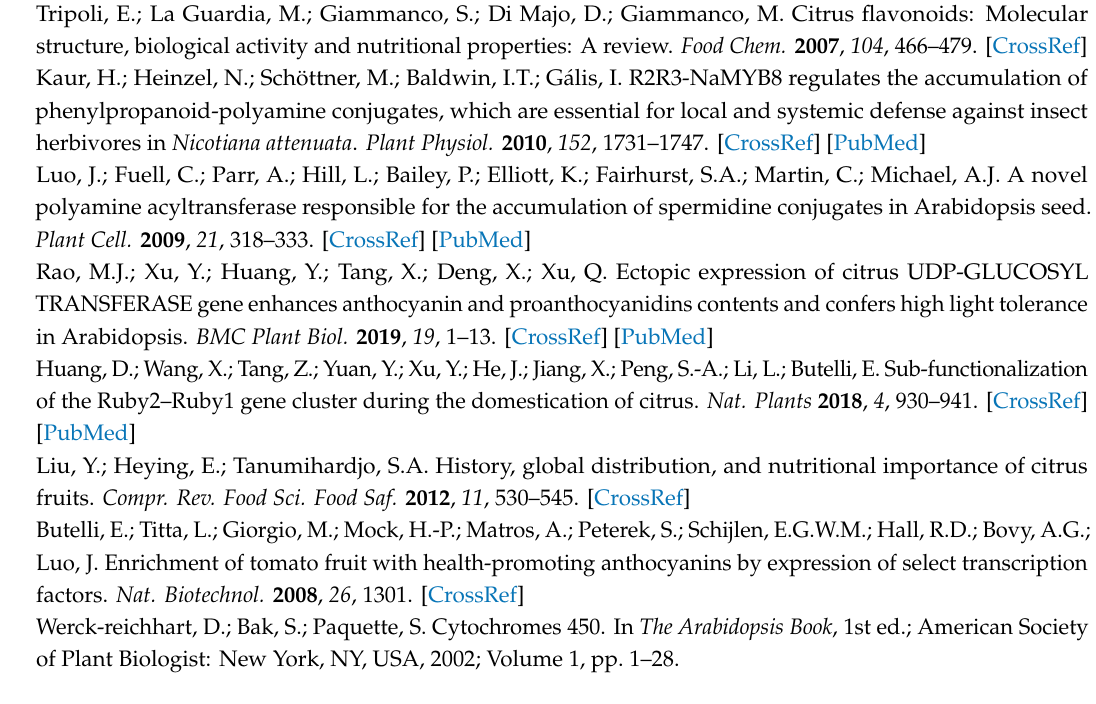
Figure S1. Heat map and hierarchical cluster analysis (HCA) performed by using the square of peaks of detected metabolites in di ff erent citrus germplasm. Figure S2. The gene expression pattern in citrus species at di ff erent stages. Figure S3. The gene expression results under drought and high light stress on Citrus sinensis leaves. Figure S4. The gene expression data of di ff erent genes that were directly or indirectly involved in the biosynthesis of flavonoids. Table S1. The Arabidopsis thaliana primers sequence that was used for q-PCR and gene IDs of the transcription factor sand enzymes that involved in the flavonoid and anthocyanin pathway. Table S2. The raw details and modes of the metabolites used in this study. Table S3. The qPCR primer sequence for the citrus varieties used in this study for gene expression analysis. Supplementary File S2. Raw transcriptome data of sweet